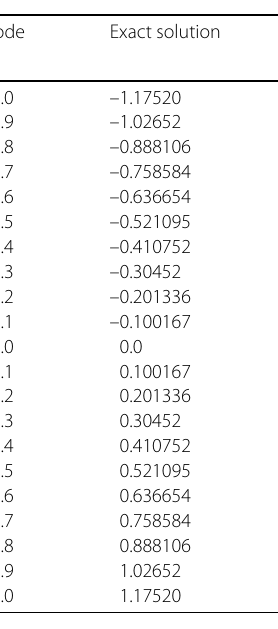
Table 2 Absolute error for Example